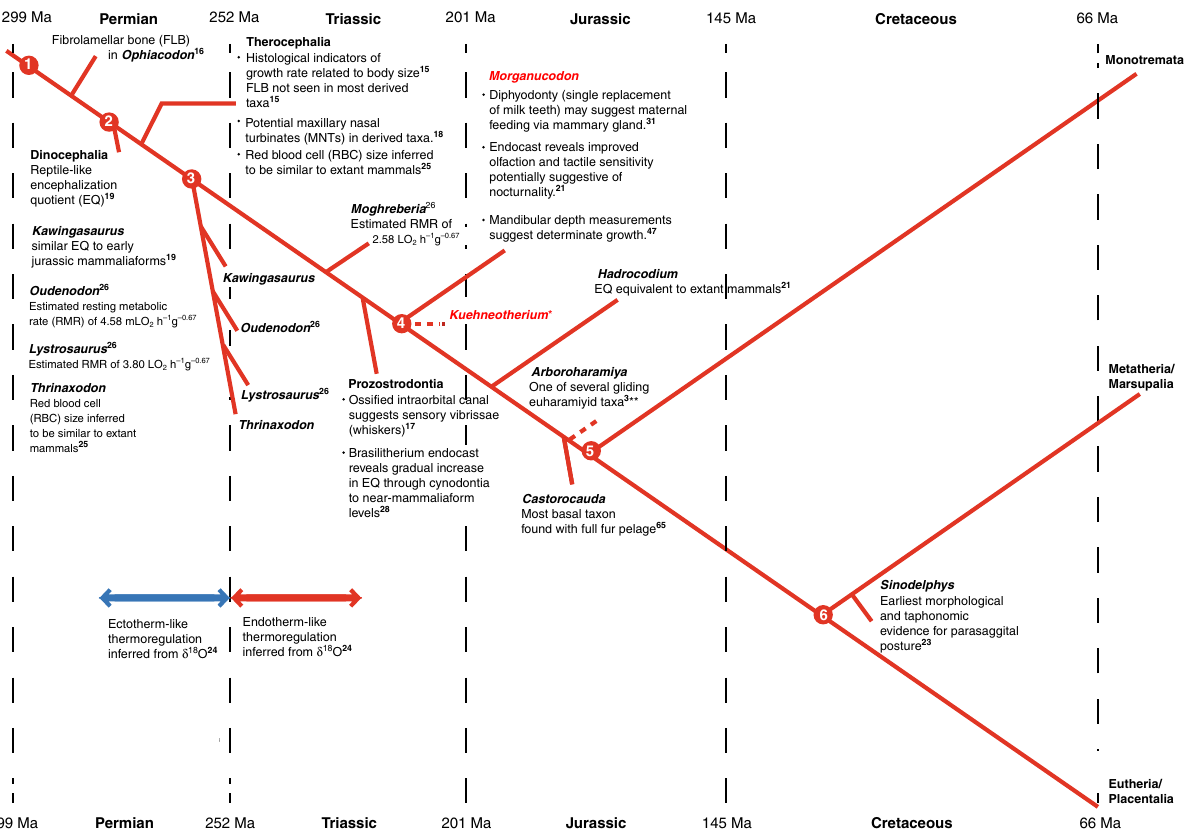
Fig. 2 Time-scaled phylogeny summarizing evidence for physiological evolution along the synapsid lineage towards mammals. Red nodes highlight the divergence of major lineages; Node 1 = divergence of the Pelycosaur lineage; Node 2 = the Therapsida clade; Node 3 = the Cynodontia clade; Node 4 = the Mammaliaformes clade; Node 5 = the Mammalia clade; Node 6 = the Theria clade. Superscript numbers denote references in the main text. Single asterisk (*) denotes the uncertain phylogenetic af fi nities of Kuehneotherium within the Mammaliaformes clade 31 . Double asterisks (**) denote the uncertain phylogenetic af fi nities of Arboroharamiya 3